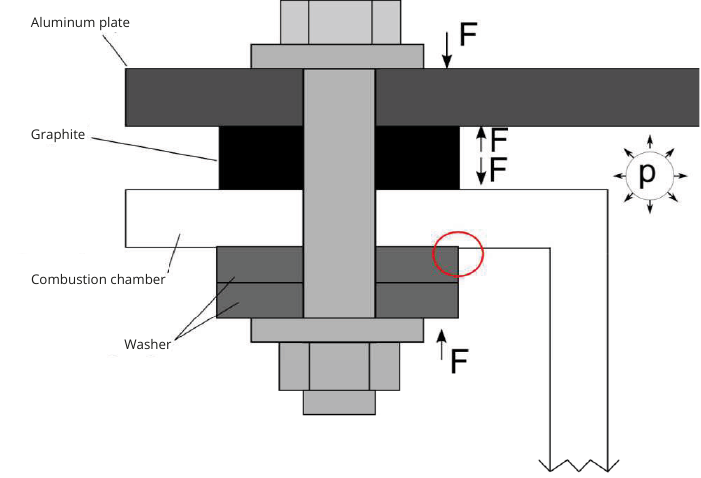
Figure 24. Illustration of the shear stress identified as the cause of failure using a sketch of the flange area (the red cirle highlights the origin of the failure cause).